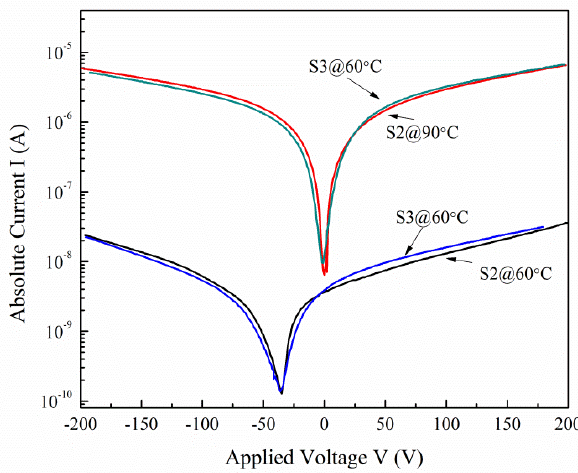
Figure 6: Cyclic I-V curves for S2 (10 vol.% choloroform) nanocom- posites at 70 ∘ C and 100 ∘ C